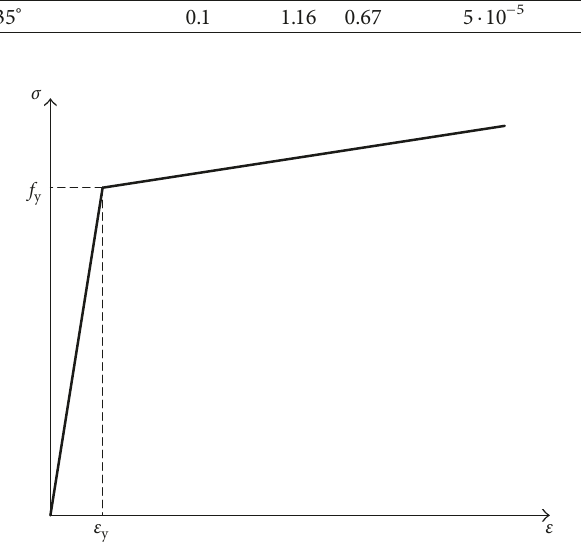
Table 3: Additional parameters for the CDP model. Dilation angle Eccentricity f b0 / f c0 K Viscosity parameter